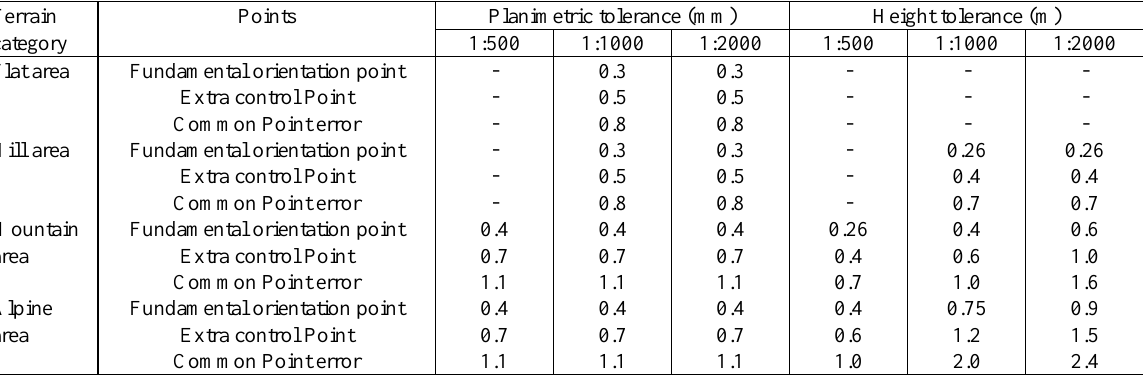
Table 1. Accuracy control index in mapping process